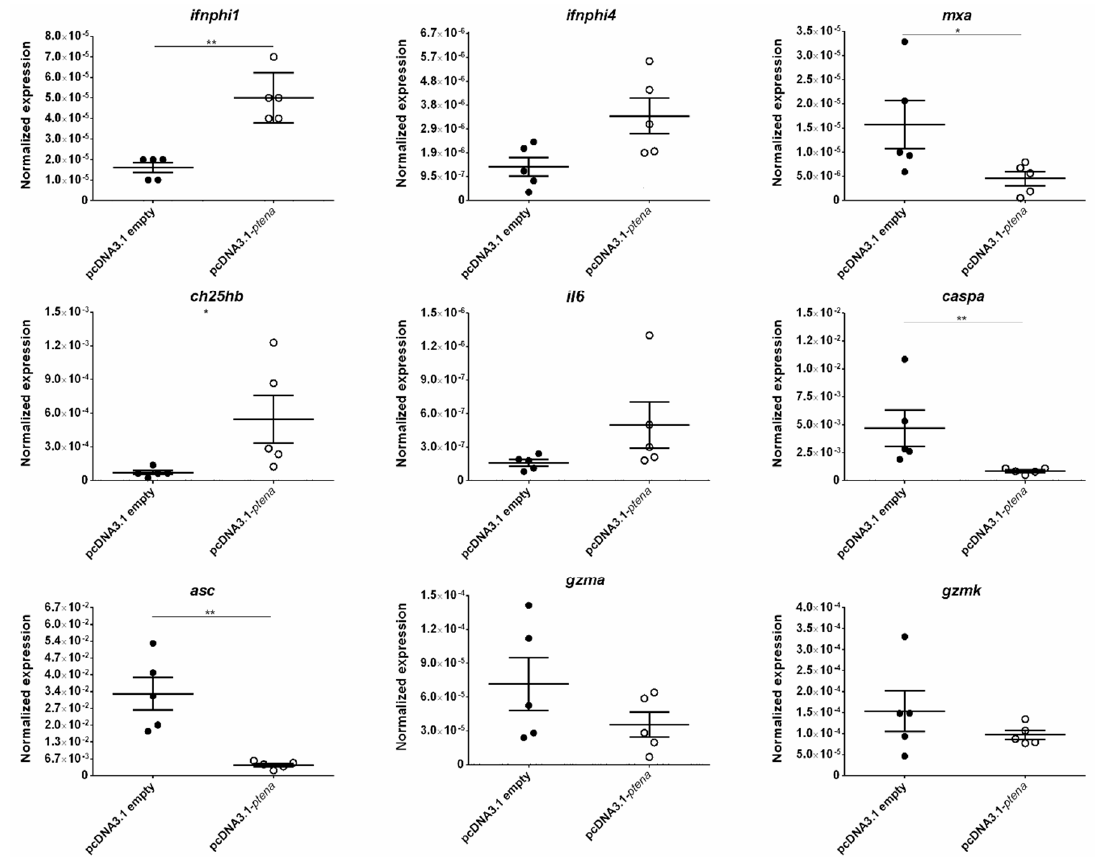
Figure 9. Effect of gene rescue on the expression of dysregulated genes in ptena mutant zebrafish larvae. The expression of the different genes was normalized to the expression of the 18S ribosomal RNA gene. The graphs represent the means ± SEMs of 5 biological replicates. Statistically significant differences are displayed as ** (0.001 < p < 0.01) or * (0.01 < p < 0.05).